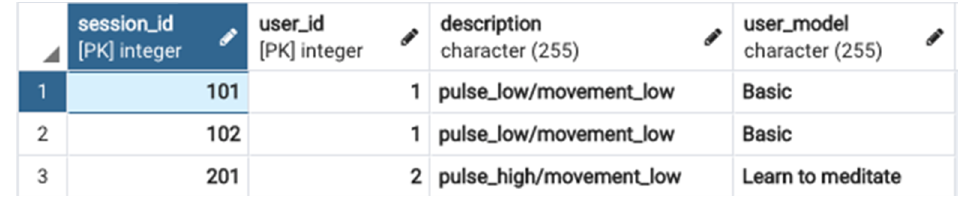
Figure 25. Example of data in the “Session” table.